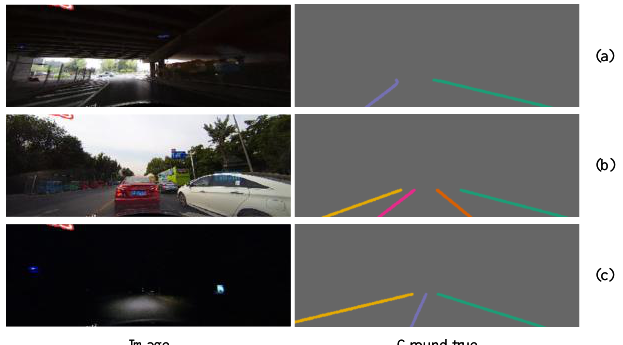
Figure 8. The CULane dataset contains a variety of challenging scenarios: ( a ) the ratio of light to dark in the image under the overpass is very large; ( b ) the traffic on the road is crowded, and the blocked lanes are also marked according to the context; ( c ) the night scene is extremely dark, and the visibility of the lanes is poor.